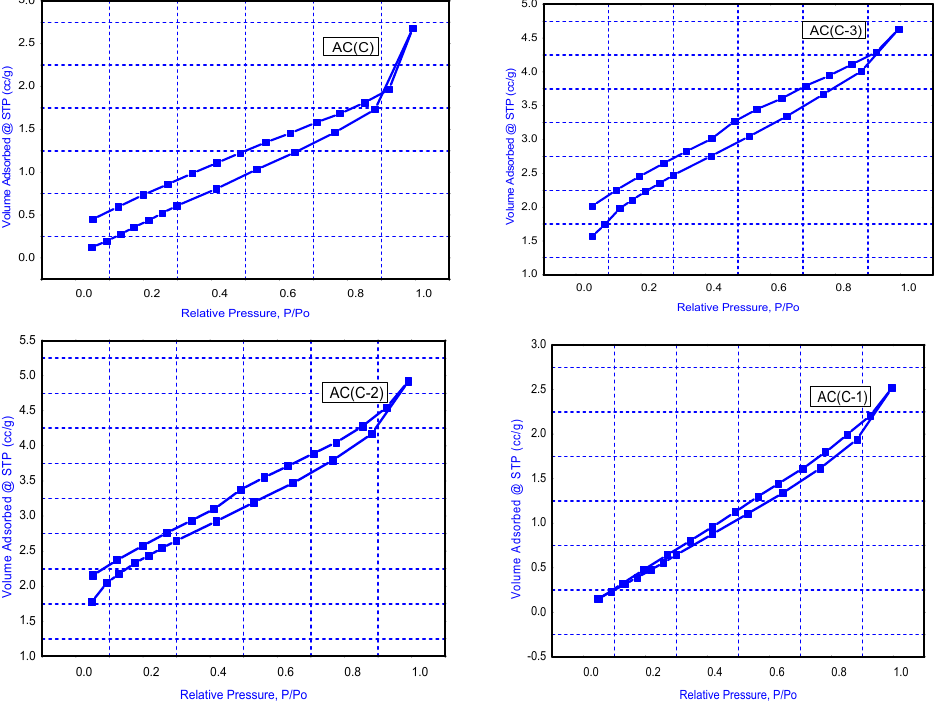
Figure 2. N 2 Adsorption–desorption isotherm of the prepared activated carbons AC(C-3), AC(C-2), AC(C-2), and AC(C).